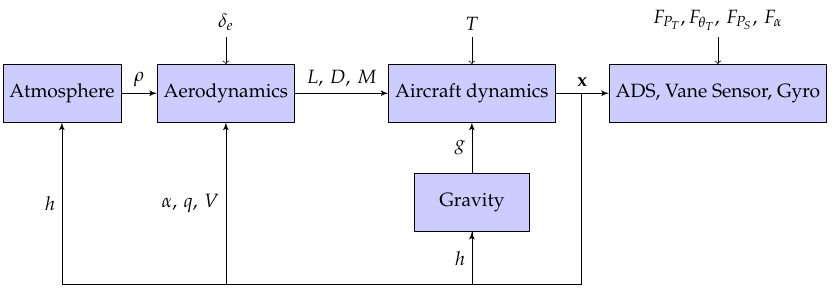
Figure 4. Simulator